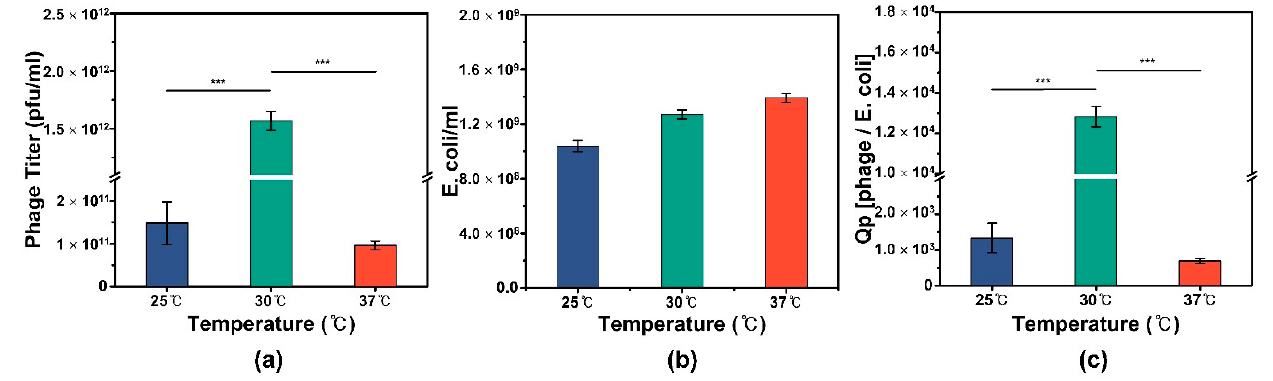
Figure 1. Phage titer, E. coli cell number (16 h fermentation), and specific productivity (Q p ) at each culture temperature. ( a ) Phage titer was measured via Blue-White screening after 16 h of fermentation in an XL1-Blue E. coli batch culture. The highest value was identified at 30 °C culture temperature, which was 10-fold the value at 25 °C and 16-fold the value at 37 °C. ( b ) E. coli cell number after 16h of fermentation was estimated OD 600 measured using UV − vis spectroscopy with the correlation of 1 OD 600 = 1 × 10 9 cells per mL culture. ( c ) Q p was calculated by dividing E. coli cell number per mL culture from phage titer at each temperature and multiplying the values by ten to identify phage production efficiency per each E. coli . The highest Q p value was identified at 30 °C culture temperature, which was 9.6-fold the value at 25 °C and 18.5-fold the value at 37 °C. n = 3 for each data point. *** p < 0.001. Table 1. Amplification ratios of various M13 bacteriophage production-related studies.